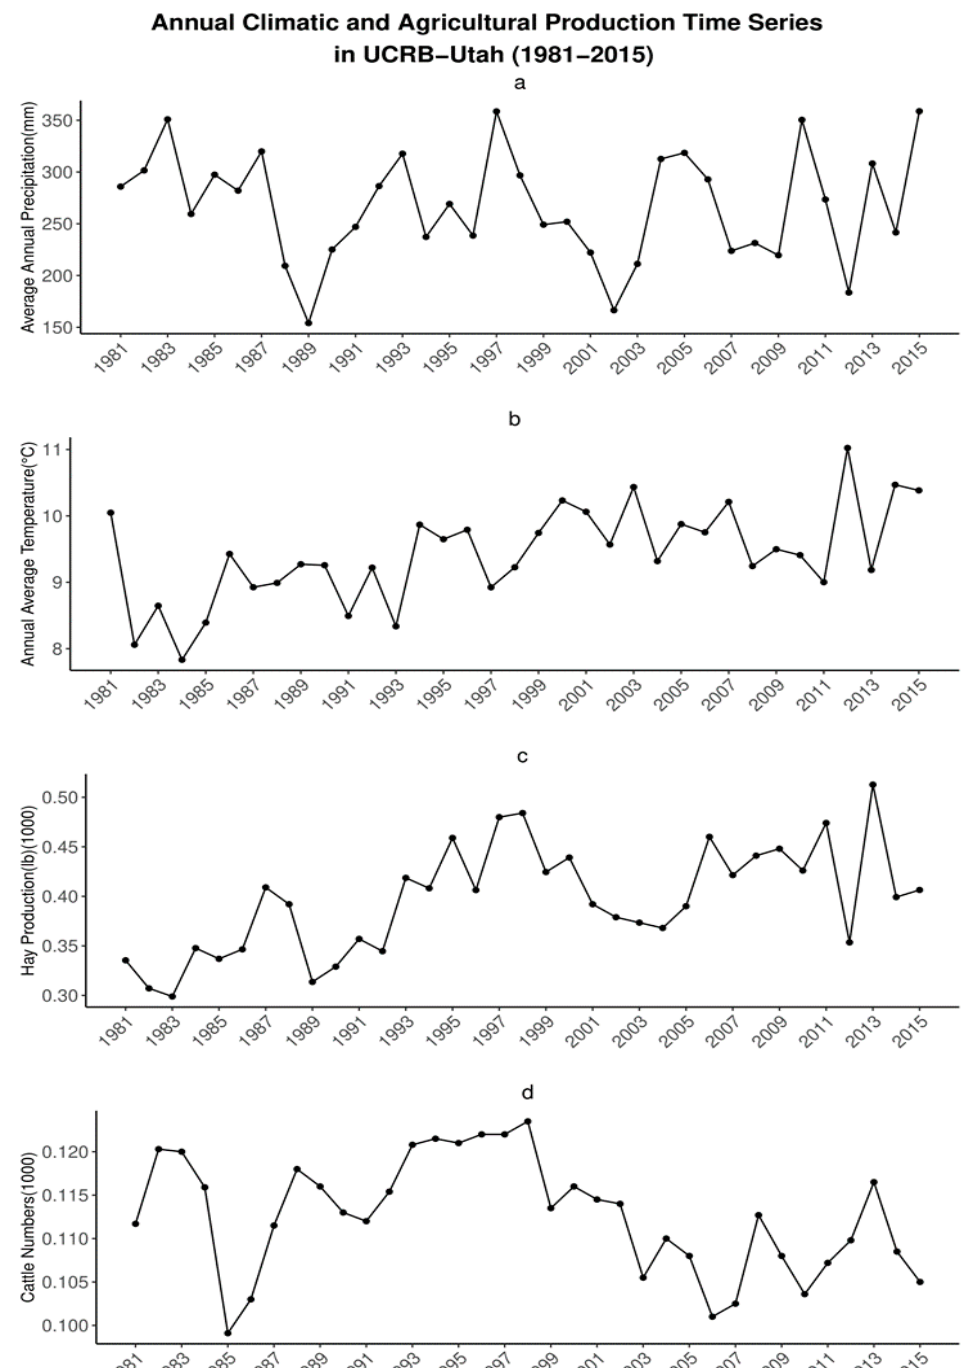
Figure 2. Annual time series for ( a ) precipitation, ( b ) mean temperature, ( c ) hay production, ( d ) cattle numbers in the UCRB-Utah region (1981–2015).